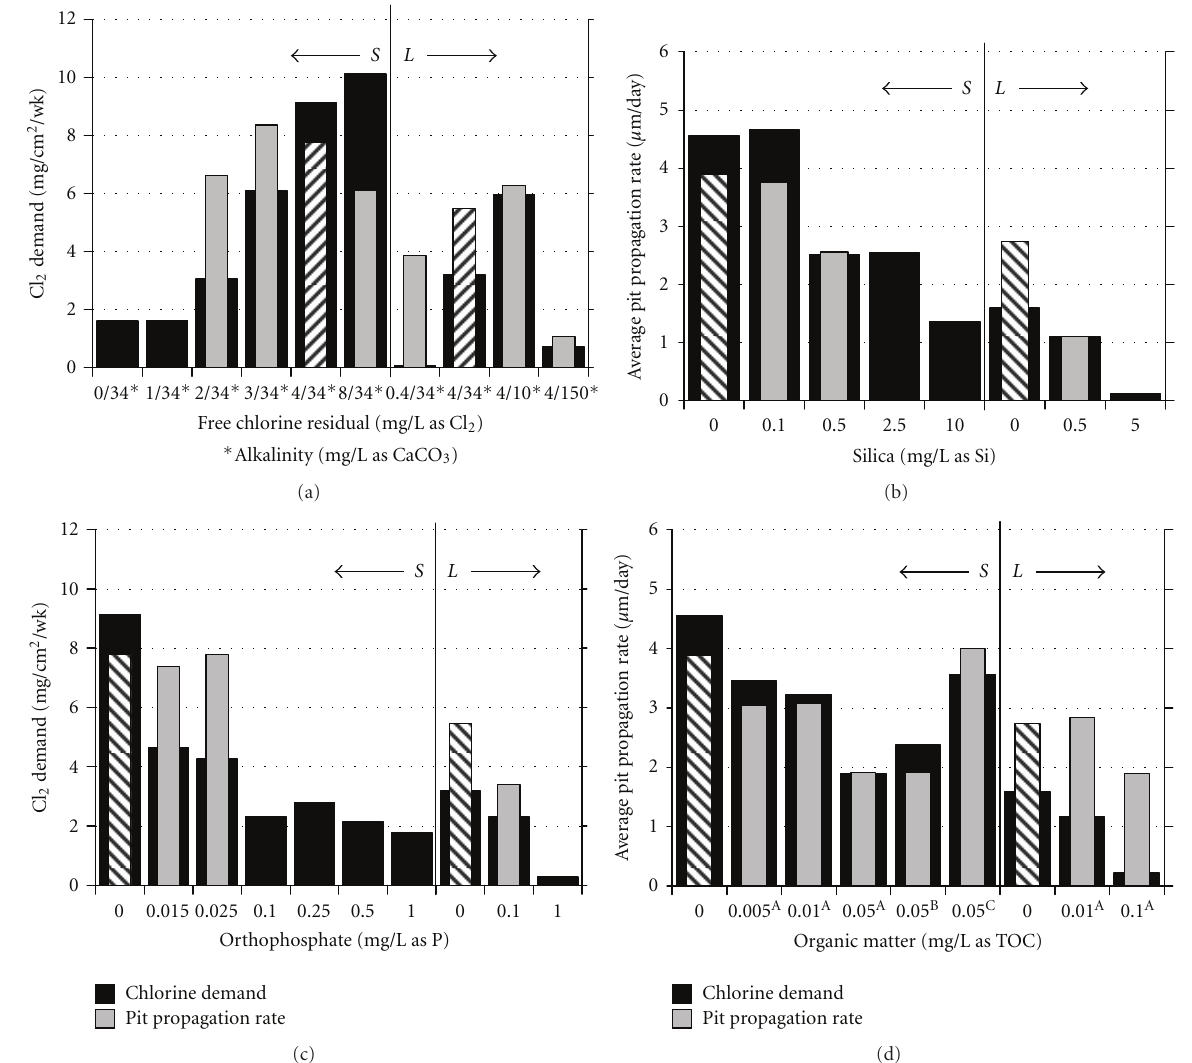
Figure 7: Chlorine demand (dark shading) and computed average pit propagation rates (light shading) based on E pit = 325 mV (versus Ag- AgCl). No propagation rate is shown for tests in which E pit was not observed. Conditions are grouped by respective changes to the control water quality ( A NOM, B ozonated NOM, C sodium acetate/d-glucose), and the control tests are shown with hash marks in each grouping. S and L indicate small- and large-scale tests,